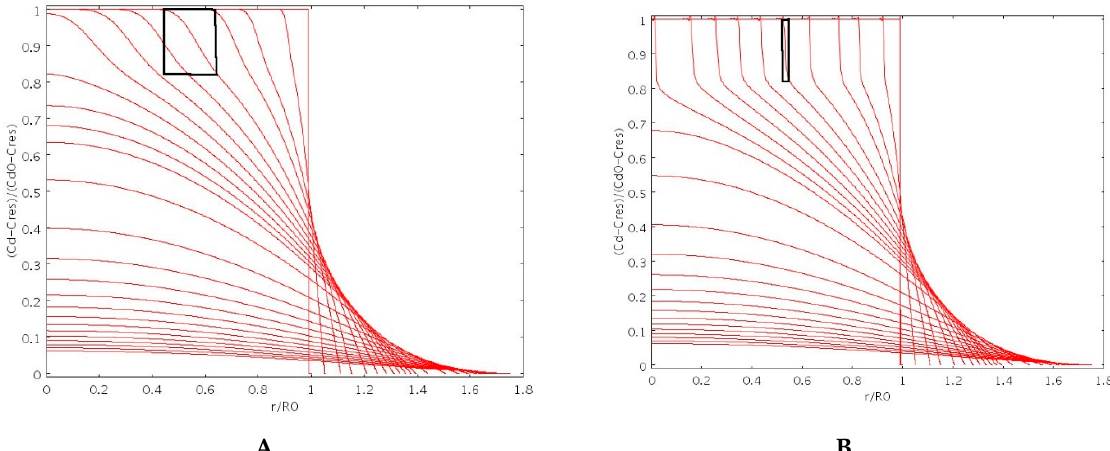
Figure 3. Normalized drug concentration (c d − C res ) / (c d0 − C res ) vs. dimensionless radius r / R 0 for increasing times as obtained by adopting β = 2 (( A ), highly porous particle) and β = 8 (( B ), non-porous particle) for particle swelling and drug transport. Black boxes highlight the thickness of the diffuse glassy-rubbery interface.